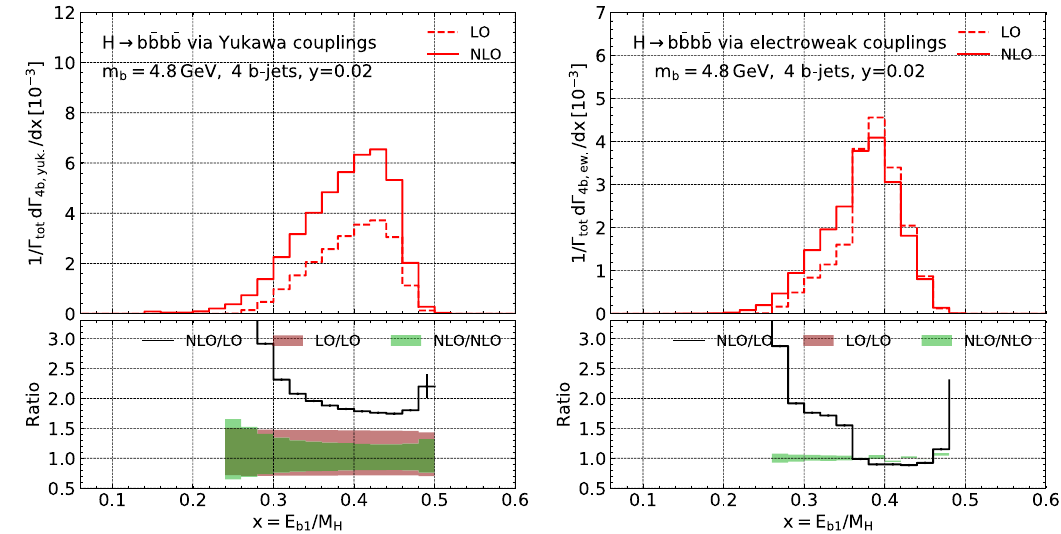
Figure 7 . Differential decay branching ratio of the Higgs boson to four bottom quarks as a function of the energy of the leading b -jet, via the Yukawa couplings (left plot) and electroweak couplings (right plot), at both LO and NLO.